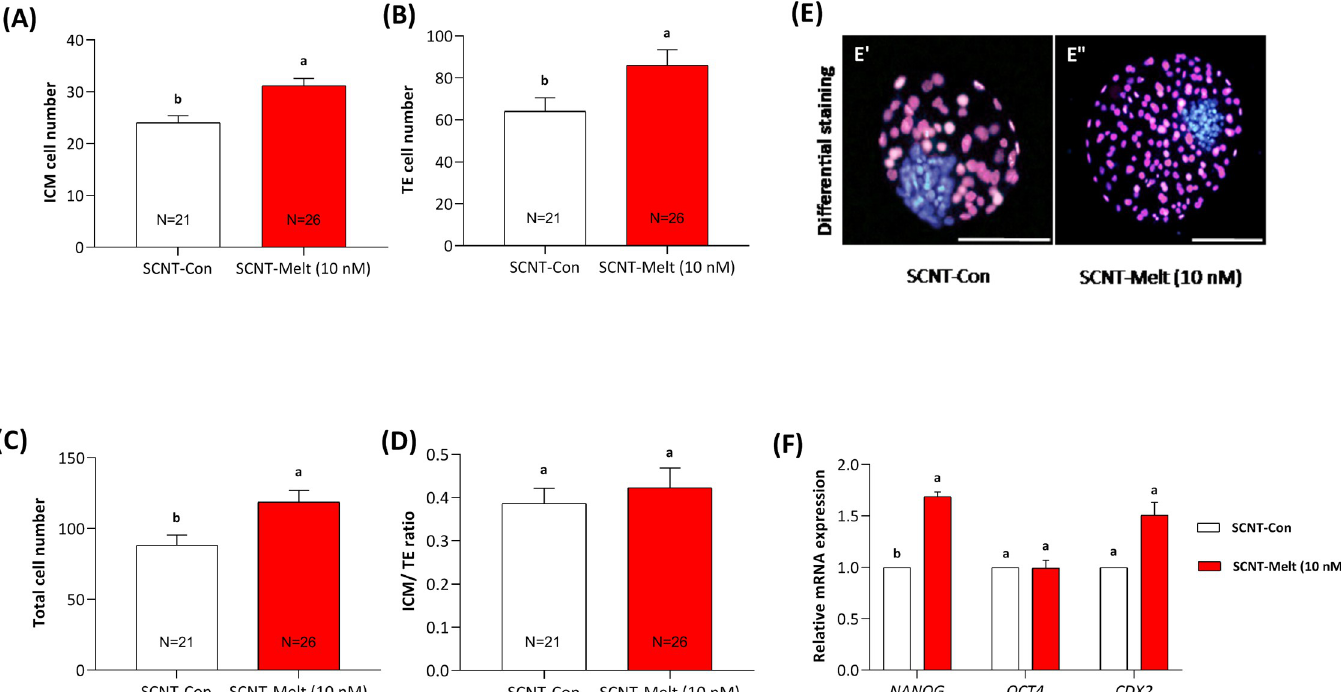
Fig 1. The effect of melatonin on the quality of ovine SCNT blastocyst embryos. The number of A) ICM, B) TE, C) TCN and D) ICM/ TE ratio that was assessed by differential staining of derived blastocysts. E) Representative images from differential staining of blastocysts derived from control and melatonin-treated groups. Scale bar, 100 μ m F) The relative mRNA expression level of pluripotency and trophectodermal genes ( OCT4 , NANOG and CDX2 ) in SCNT blastocysts from SCNT-Melt (10 nM) and SCNT-Con groups. The data were shown as mean ± SEM. Values with different letters have a statistically significant difference ( P < 0.05).